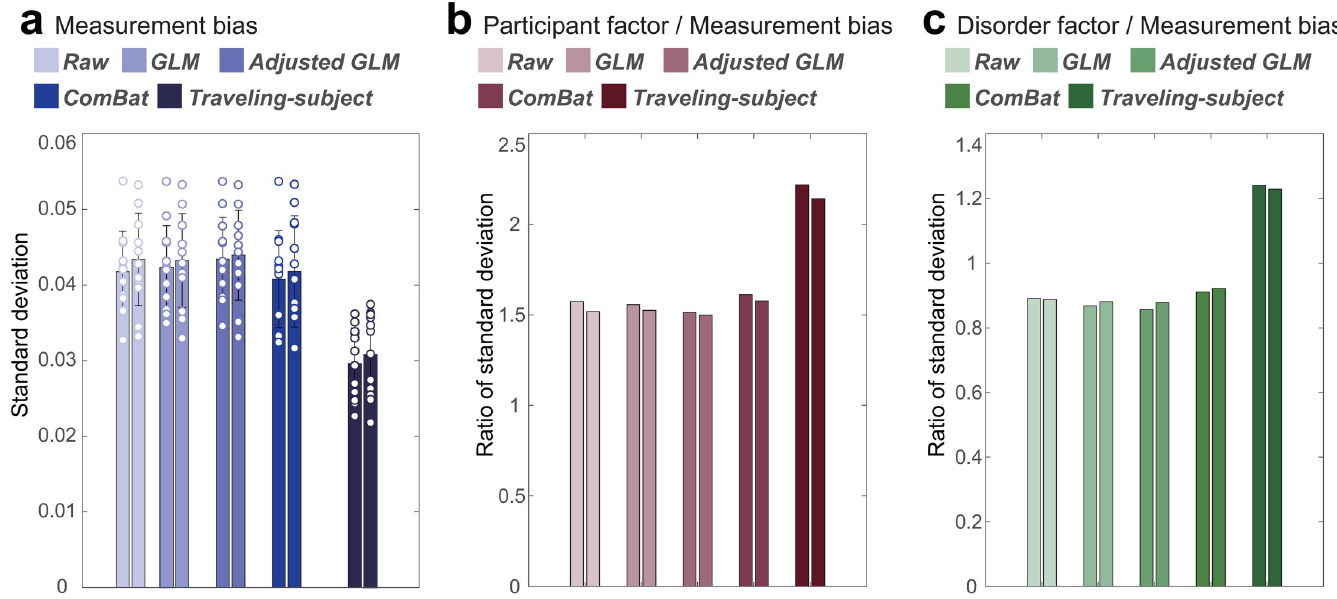
Fig 7. Reduction of the measurement bias and improvement of signal-to-noise ratios for different harmonization methods. (a) Standard deviation of the magnitude distribution of the measurement bias. The error bars represent the standard deviation across sites. Each data point represents one site. (b) Ratio of standard deviation of the magnitude distribution of the measurement bias to that of the participant factor. (c) Ratio of standard deviation of the magnitude distribution of the measurement bias to that of the disorder factor. Different colored columns show the results from different harmonization methods. Two columns of the same color show the results of the two folds. The numerical data used in this figure are included in S1 Data. GLM, generalized linear